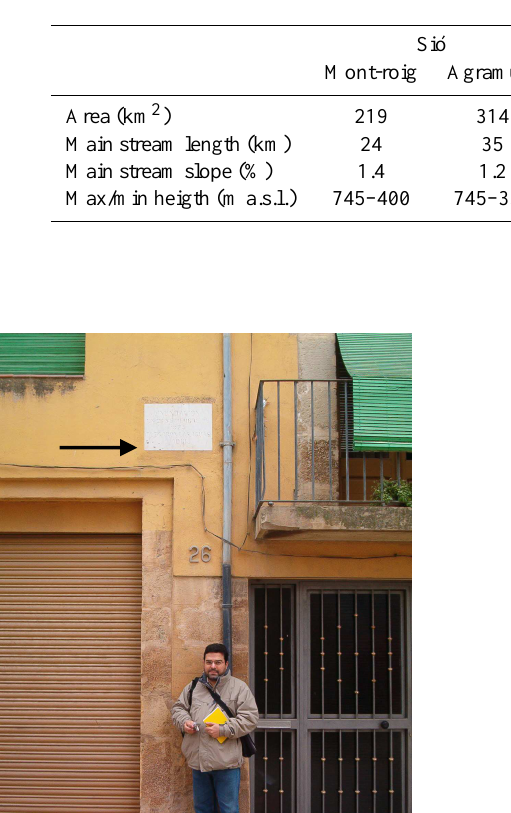
Table 1. Morphological and hydrographical characteristics of Si´o, Ondara and Corb basins.